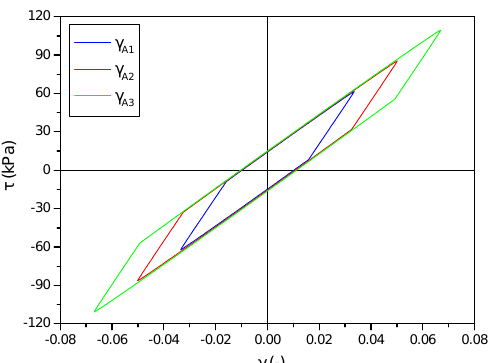
Figure 8. Identification results. Hysteresis loops obtained from the model for three values of deformation amplitude and the set value of magnetic field.